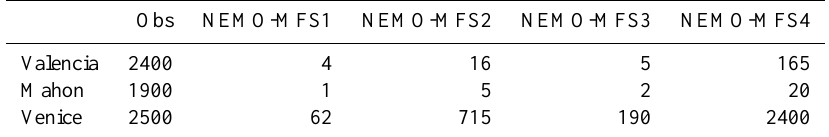
Table 2. Energy content (cm 2 ) in the period bands between 12 and 2h in the three selected stations.